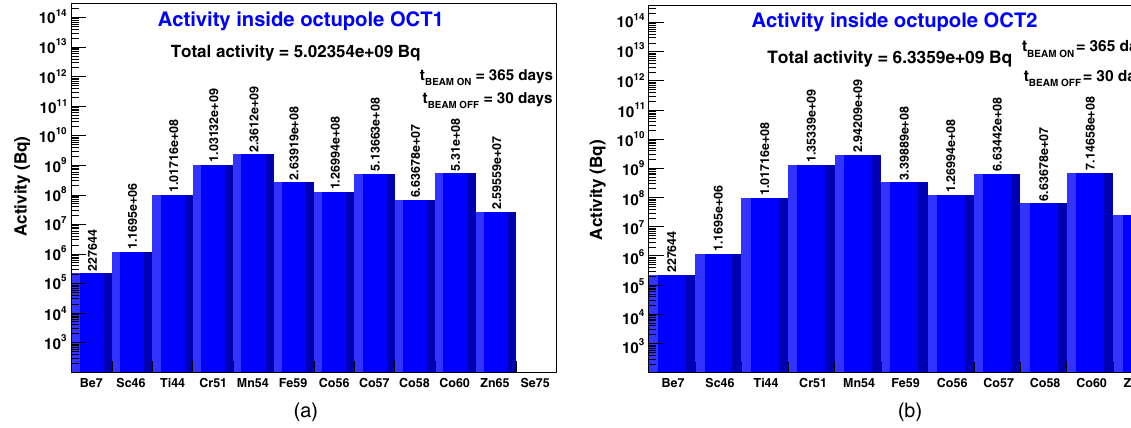
FIG. 10. Induced activity for the HEBT-S3 octupoles: (a) octupole OCT1 and (b) octupole